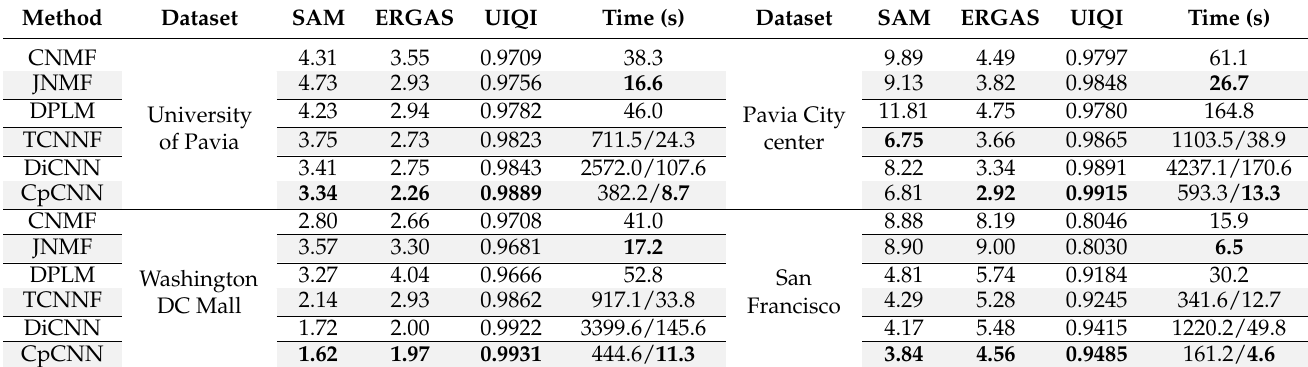
Table 2. Numerical evaluation of hyper-sharpening results under resolution ratio of 4 ( s =